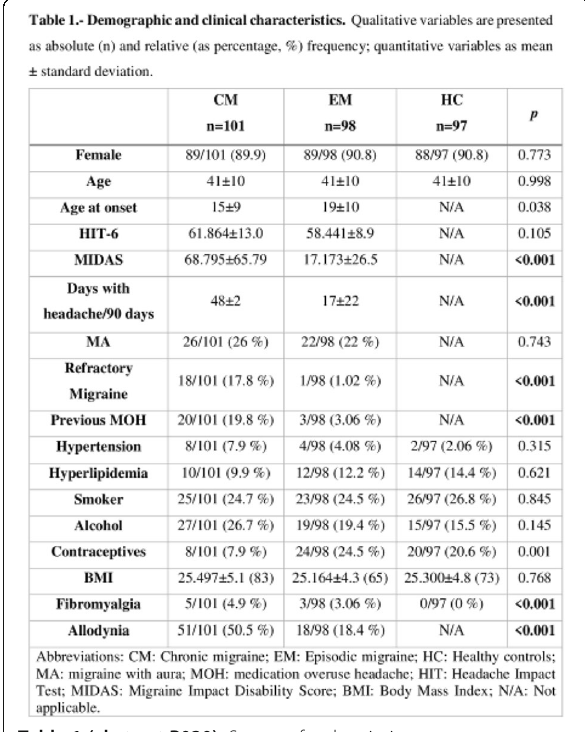
Table 1 (abstract P030). See text for